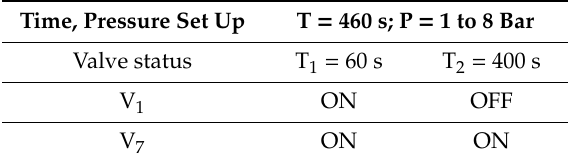
Table 3. Set up parameters for the experimental process from 1 bar to 8 bar.